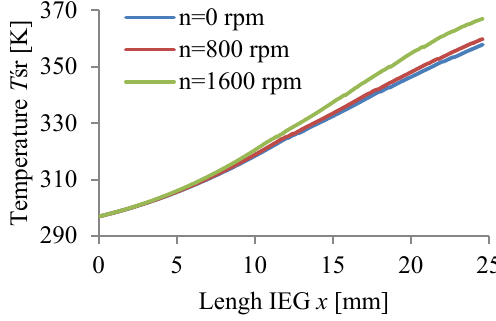
Figure 9. Pressure distribution p .